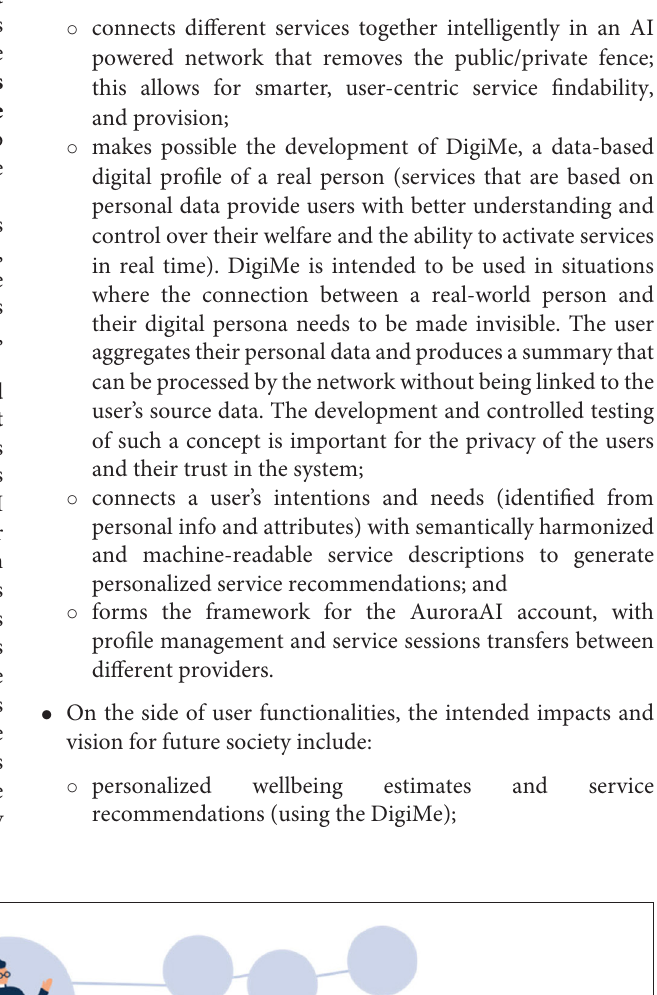
Frontiers in Artificial Intelligence |